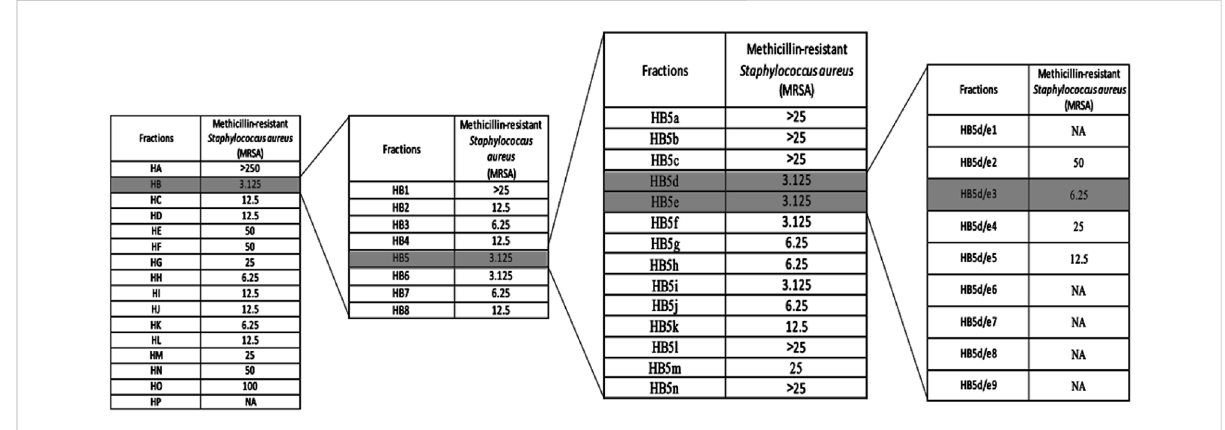
FIGURE 1 Bioassay-guided puri fi ed fractions of n-hexane extracts (MIC µg/mL). Note: NA, not